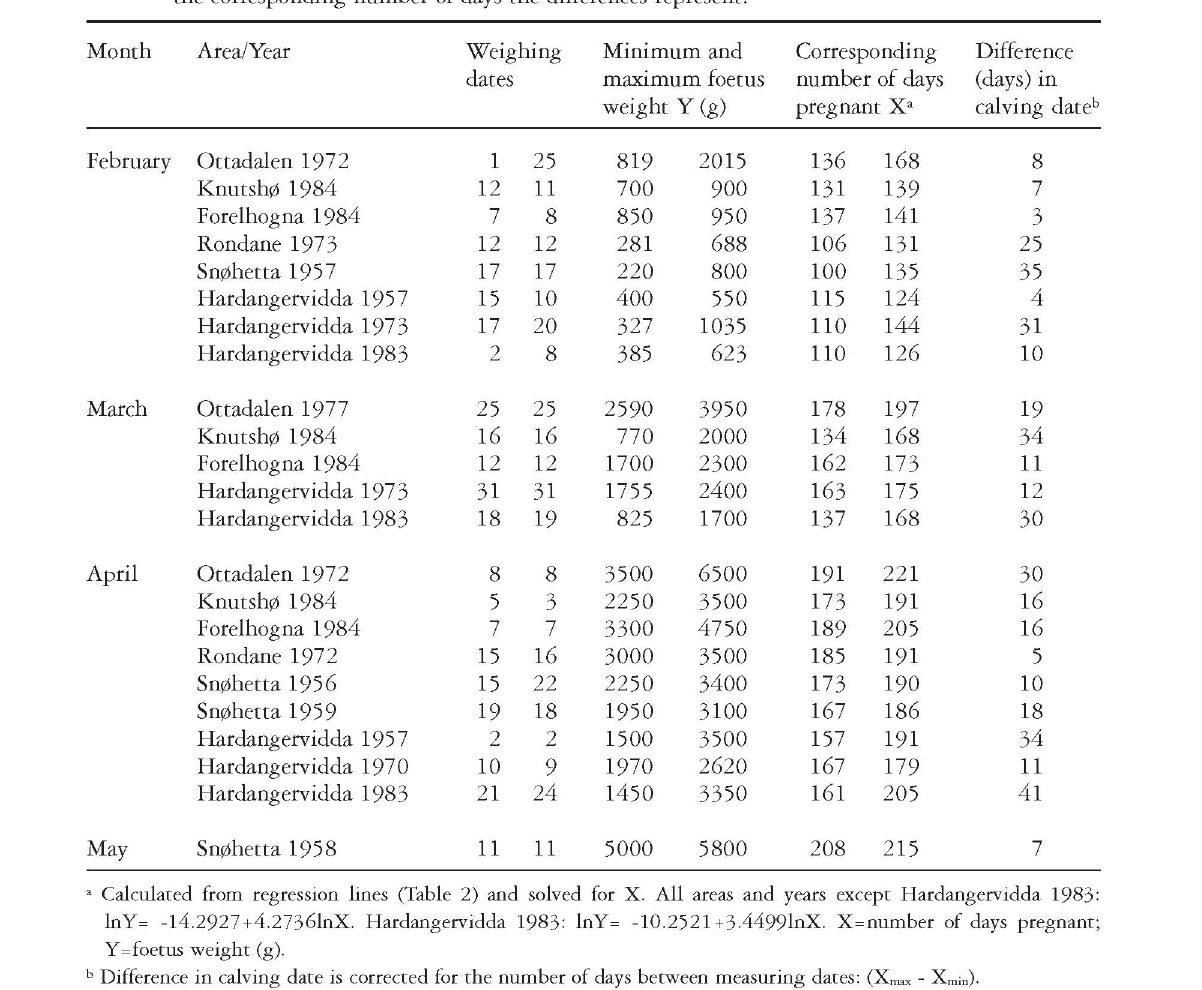
Table 3. Minimum and maximum foetus weights form pregnant females 1 yr+ sampled in Jan — May and the corresponding number of days the differences represent.